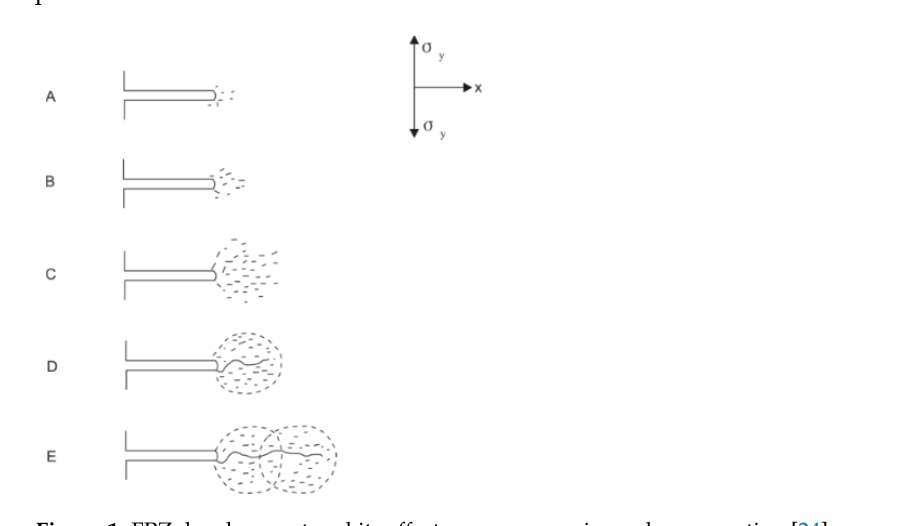
Figure 1. FPZ development and its effect on macroscopic crack propagation [24].